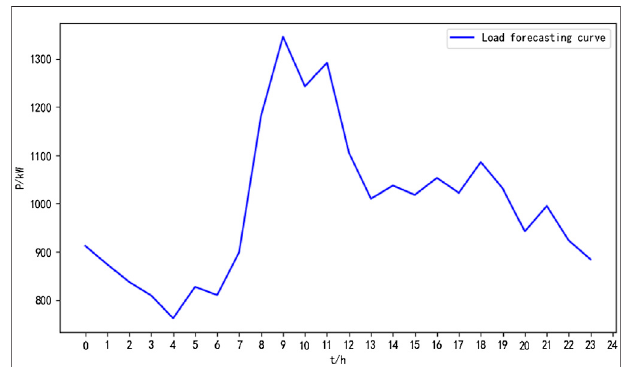
FIGURE 2 | Typical daily load forecast curve.